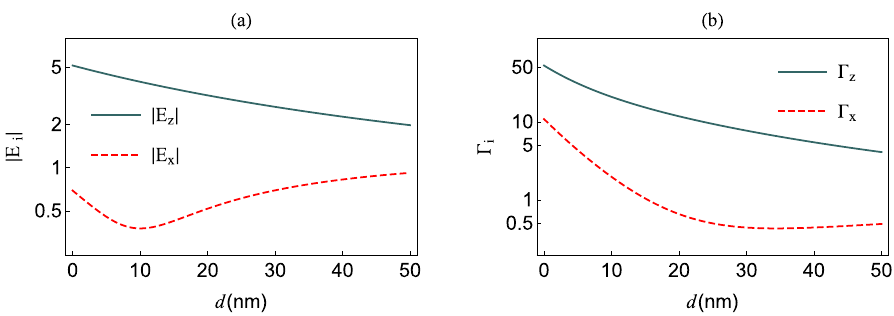
Figure 2. ( a ) The modified field factors of the field applied to the molecule and ( b ) the Purcell enhancement factors of the QS as function of the distance d of the QS to the surface of the